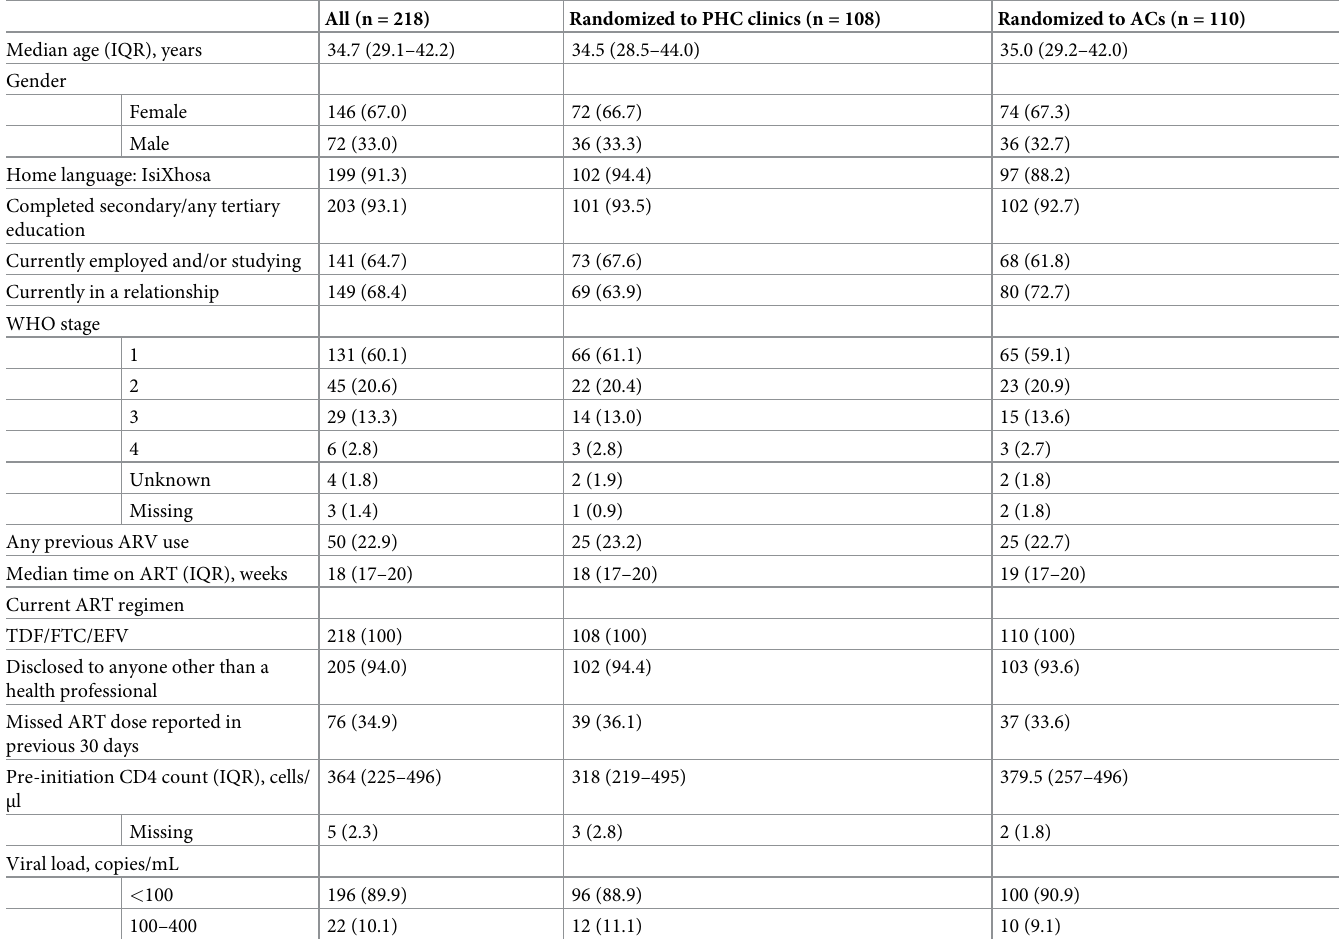
Table 1. Enrolment characteristics of the study